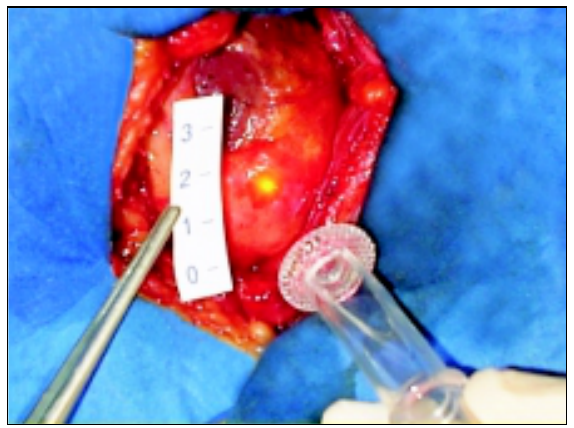
Fig. 1 - Fotografia mostrando o acesso ao coração, através de minitoracotomia realizada no quarto espaço